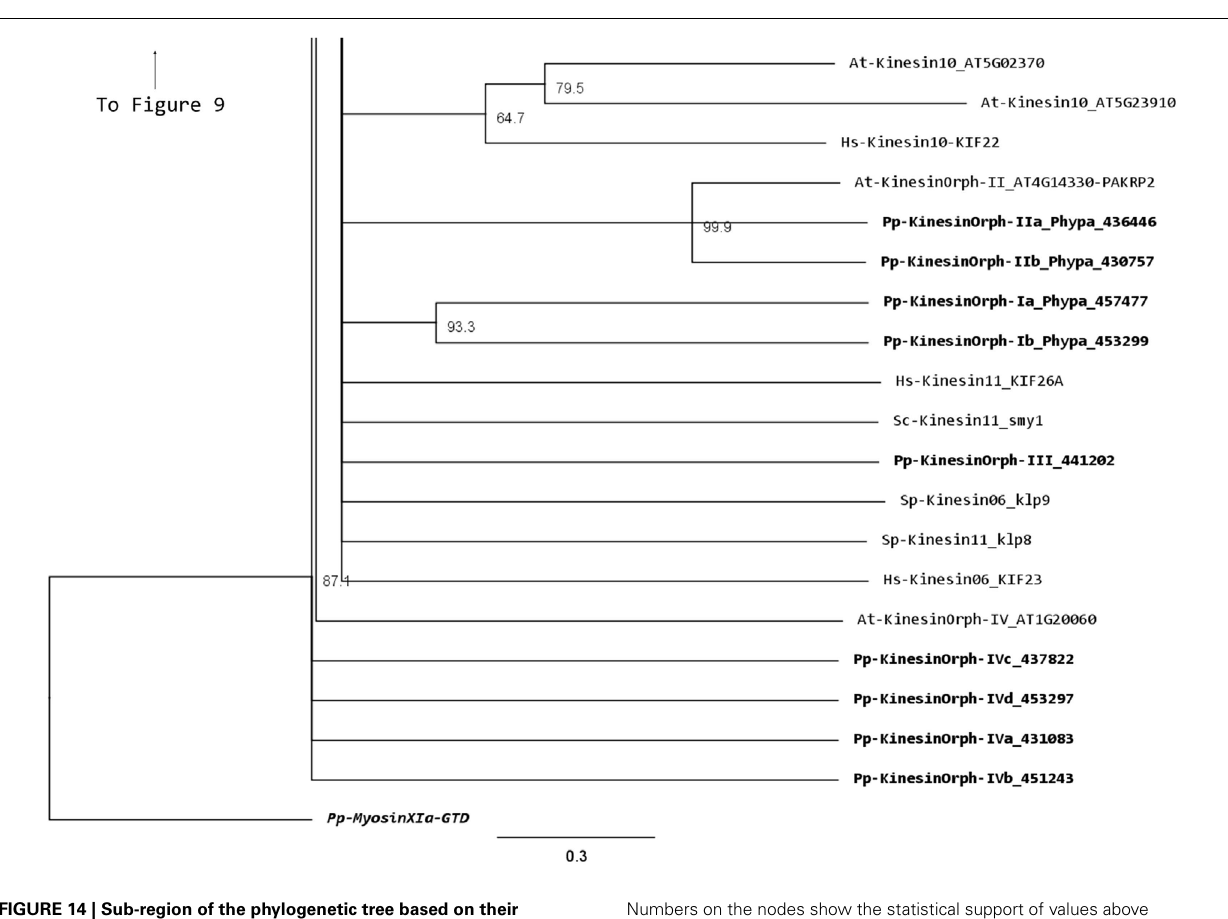
FIGURE 14 | Sub-region of the phylogenetic tree based on their motor domain showing kinesin 6s, 10s, 11s, and orphan kinesins. The amino acid sequences of the motor domain were aligned using ClustalW and the phylogenetic tree was constructed using the maximum likelihood method (PhyML) and a 1000 bootstrap resampling value.